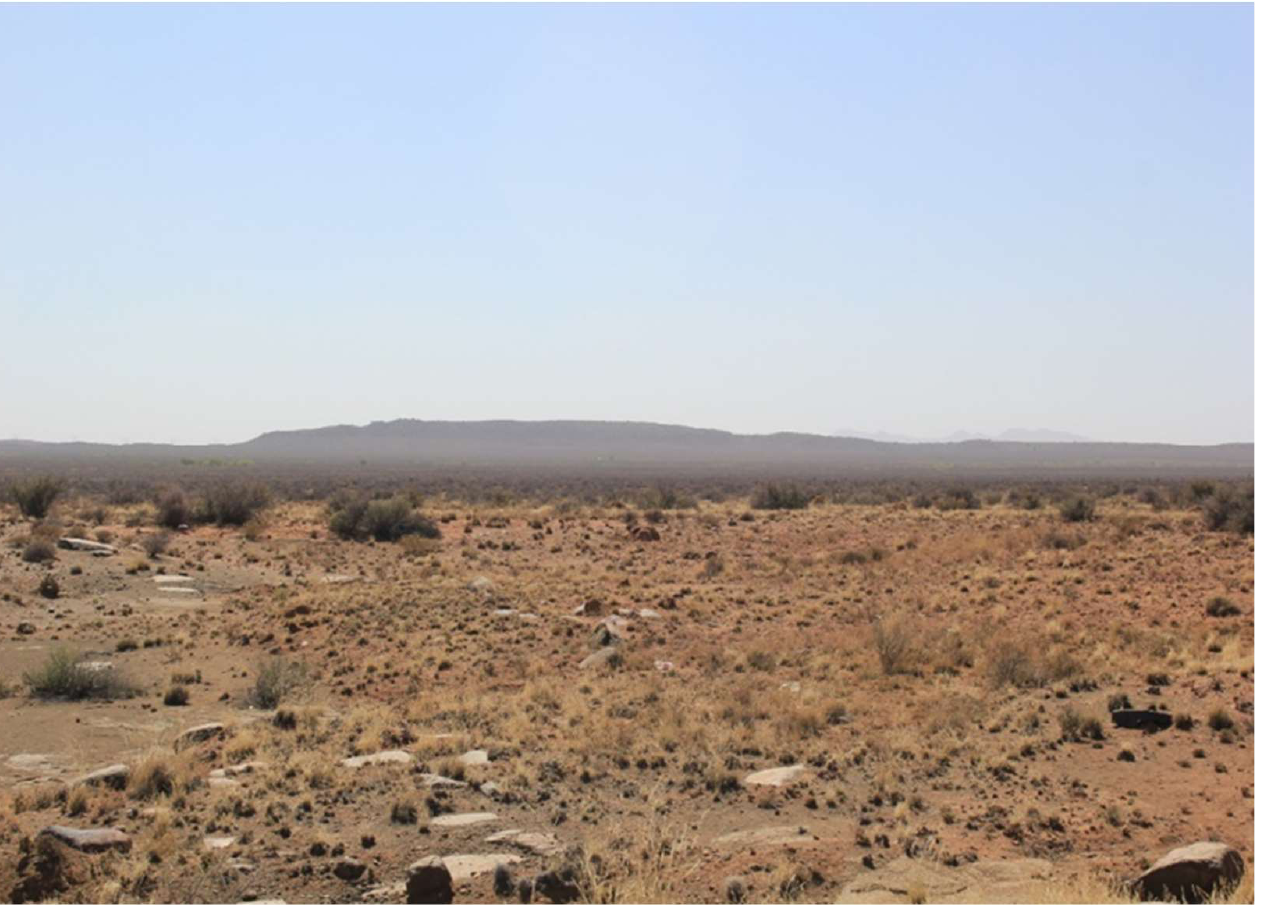
Figure 1. Drylands near Taung in the margins of the Kalahari Basin, South Africa (Image credit: B. Winkler).